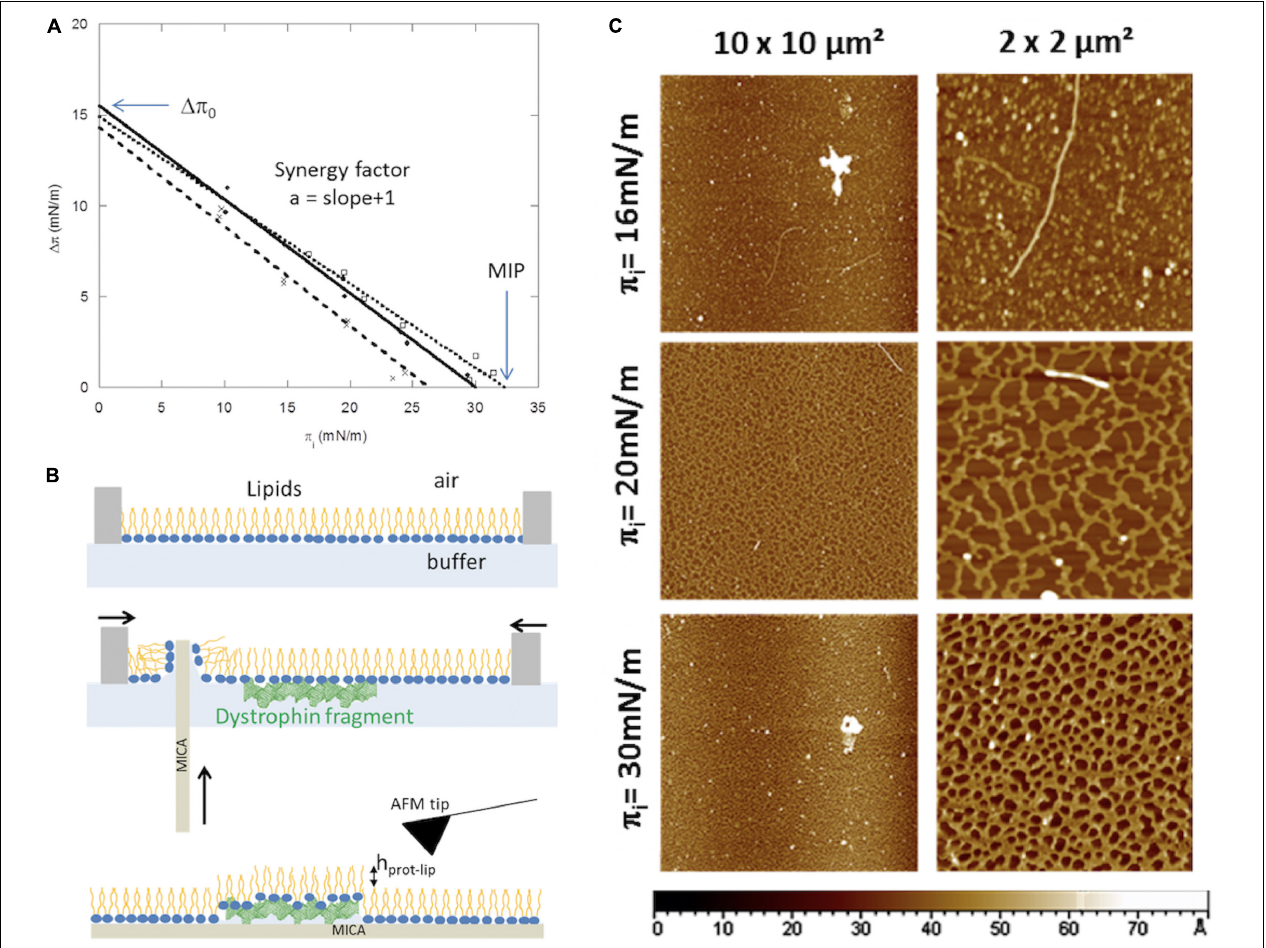
FIGURE 1 | (A) Insertion of dystrophin fragments, R4-9 (?) R11-15 ( • ) R16-21 (x), increases surface pressure of lipid monolayer and is modulated by the lipid initial surface pressure ( π i ). The maximal insertion pressure (MIP) and the theoretical pressure increase at the lipid-free interface ( (cid:49) π 0 ) are indicated by arrows. Adapted and modified from Sarkis et al. (2011) and Ameziane-Le Hir et al. (2014). (B) Schematic representation of the Langmuir-Blodgett transfer of the interfacial protein/lipid